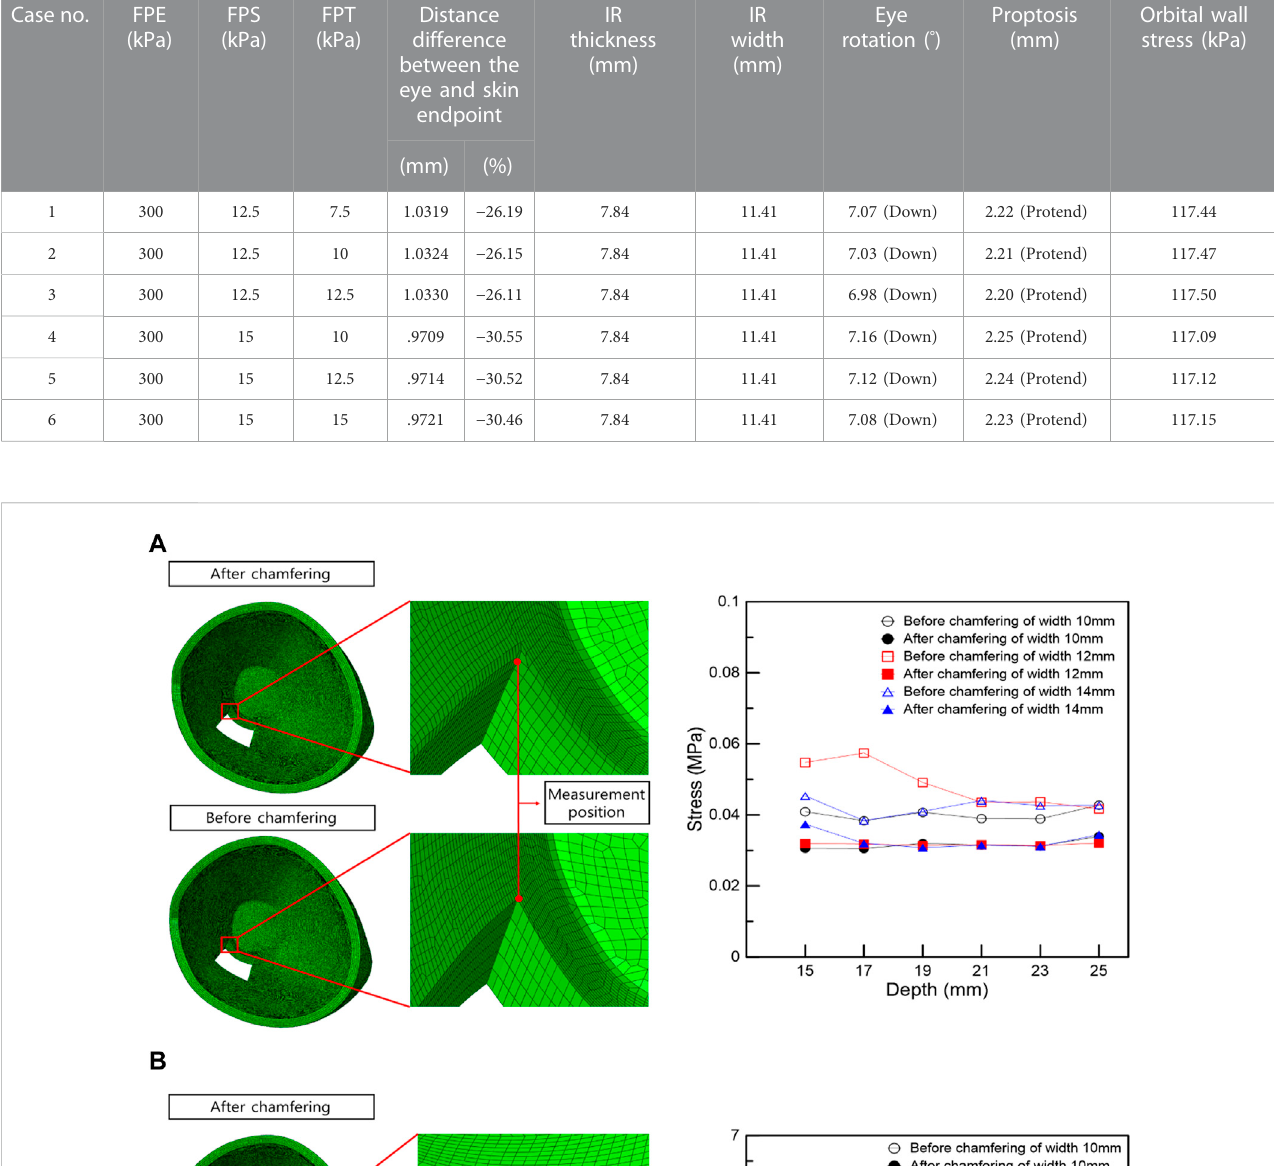
Frontiers in Bioengineering and